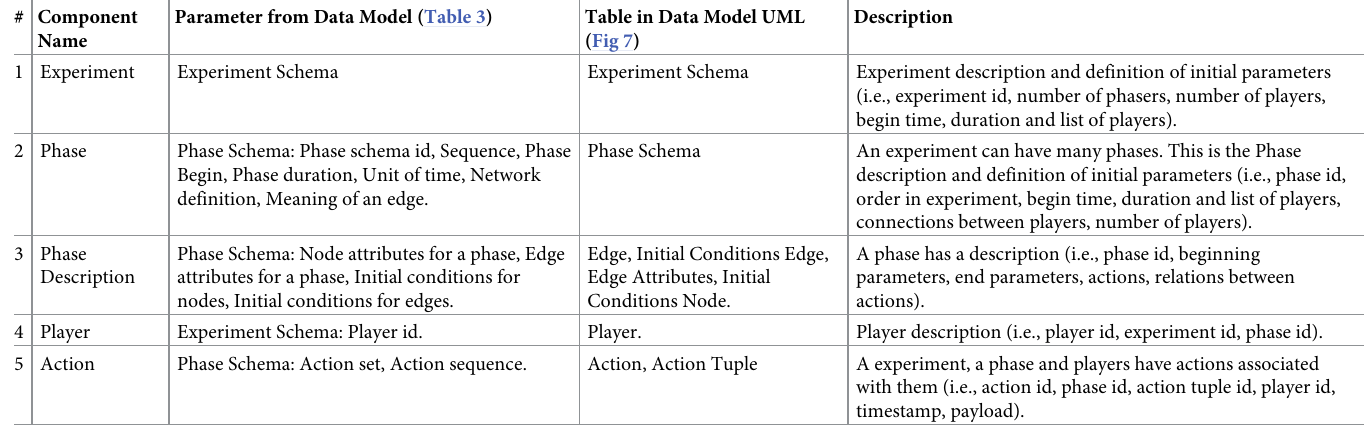
Table 8. Data common